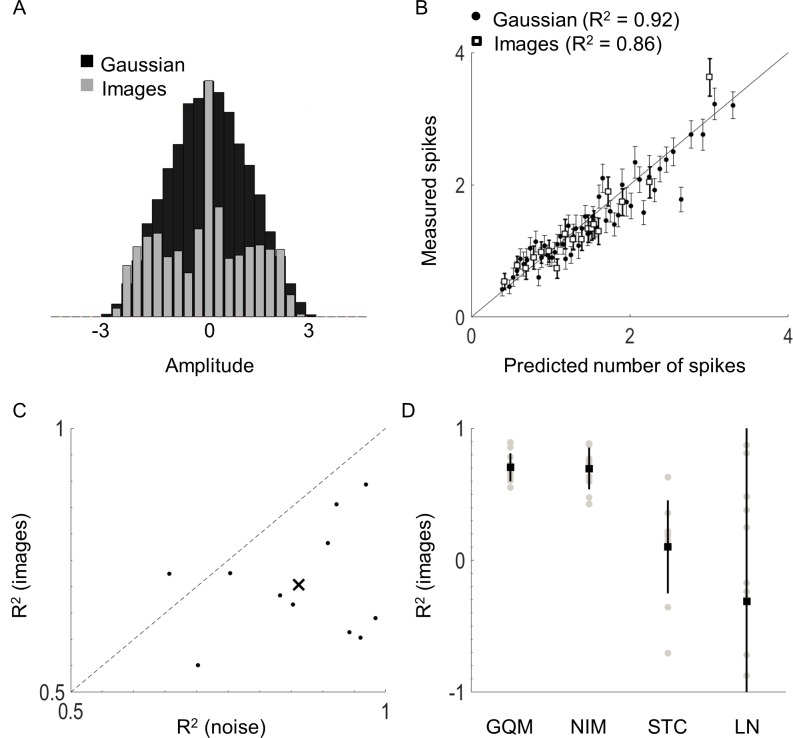
Model comparison with non-Gaussian stimuli.A) Distribution of electrode amplitudes for Gaussian and non-Gaussian image stimuli. The amplitudes in both cases have been divided by the variance of the Gaussian stimuli (i.e., the Gaussian distribution has unit variance). B) The model prediction for a sample cell is shown for Gaussian stimuli (round) and images (square). C) Coefficient of determination (R2) of the model prediction when validated with noise and with images for eleven cells. The x denotes the mean R2 for noise (0.86) and images (0.70). Dashed line represents line of equality. D) A comparison of the coefficients of determination for the general quadratic model (GQM), non-linear input model (NIM), a two-dimensional spike-triggered covariance analysis (STC2), and a one-dimension model (STC1). Squares denote the mean and lines denote ±1 standard deviation.